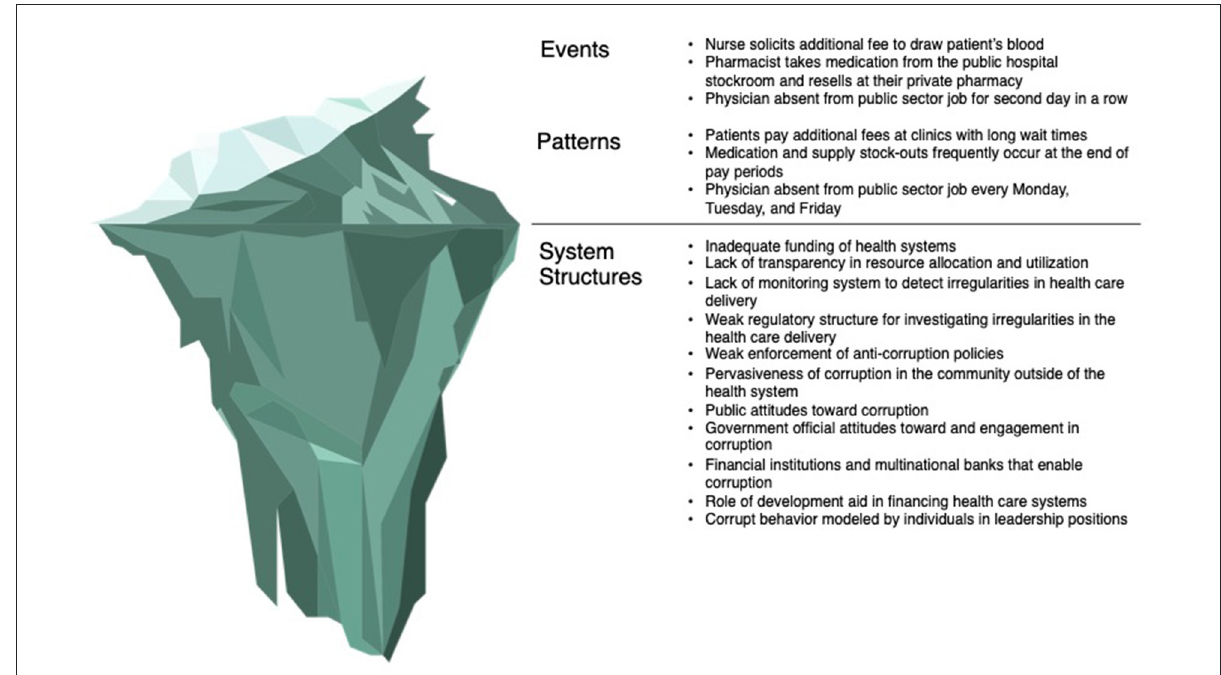
FIGURE2 Iceberg diagram of health sector